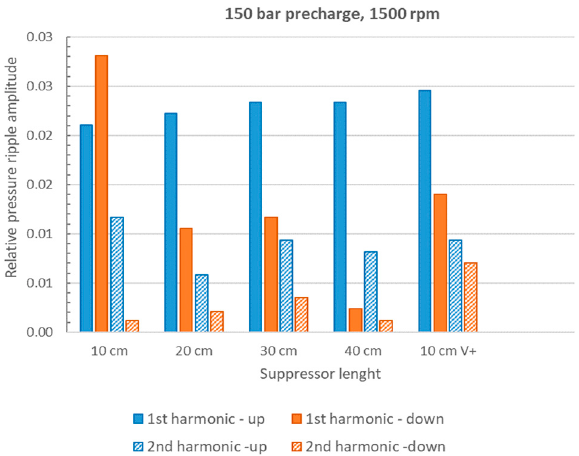
Figure 22. FFT of the pressure ripple for di ff erent damper lengths and gas volumes.